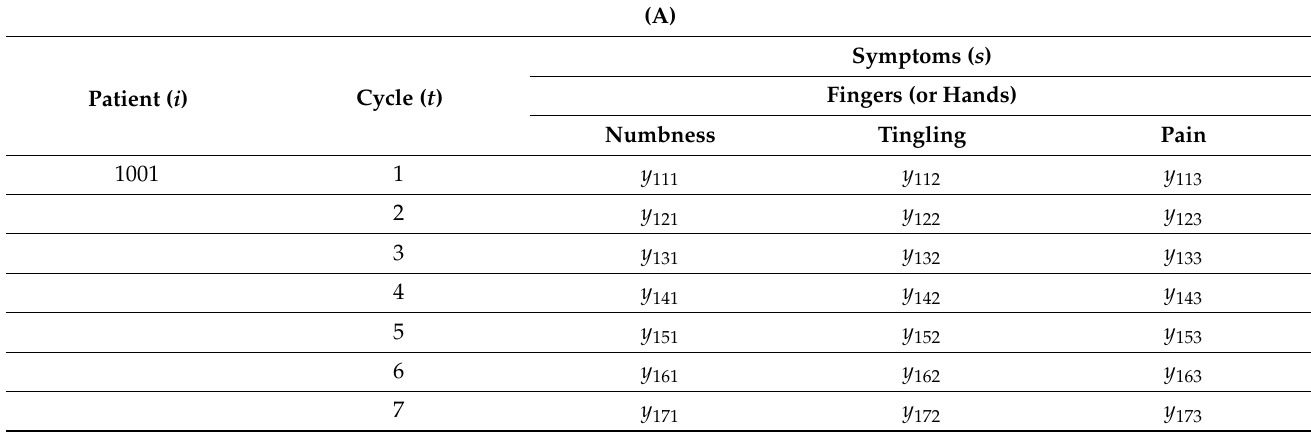
Table 1. ( A ) Format of the ordinal data in the fingers (or hands) for a single patient. ( B ) Summary of notation used in Model 1 and Model